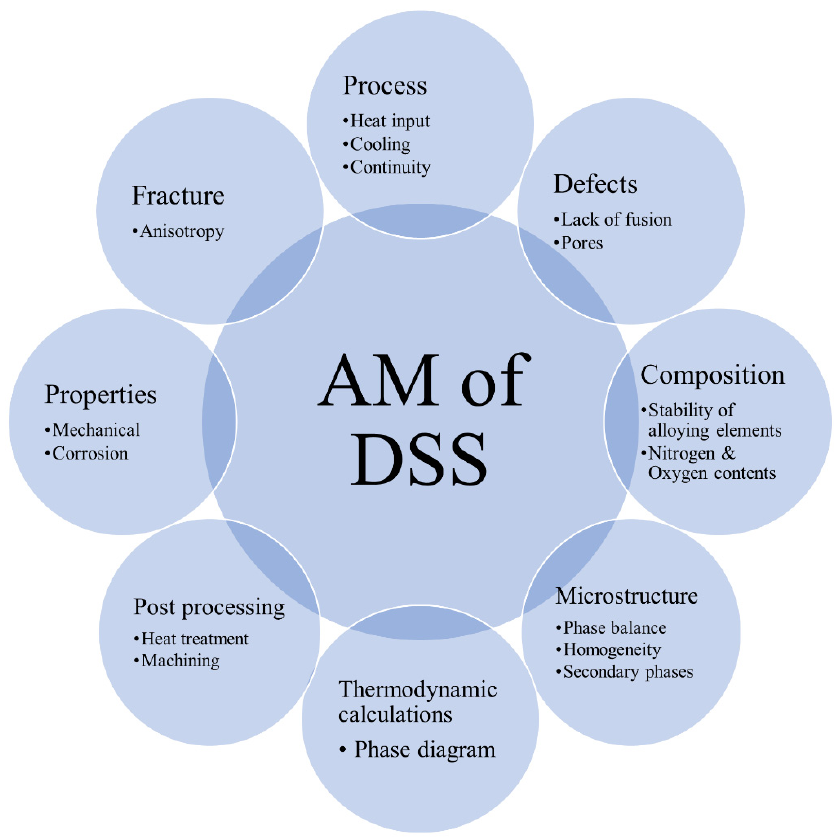
Figure 12. Important factors in additive manufacturing of duplex stainless steel components. The properties of DSS components are dictated by their microstructure, which is controlled by the chemical composition and thermal cycles. Reaching required properties and avoiding defects require implementation and control of appropriate process parameters and the use of suitable feedstock material.